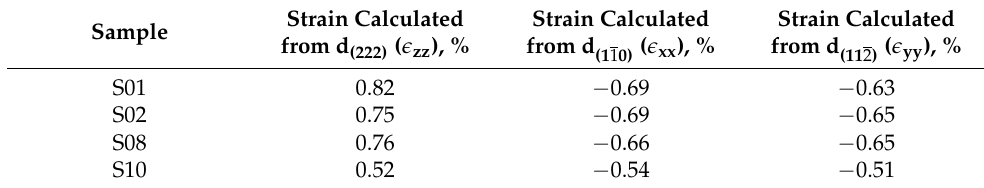
Table 2. Strain calculated from three planes for β -Bi layers with different thicknesses.